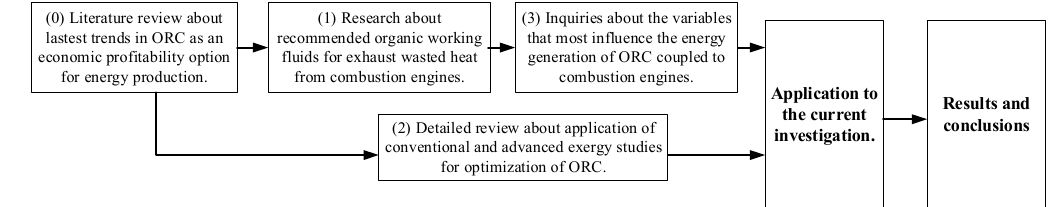
Figure 1. Flowchart of research methodology.